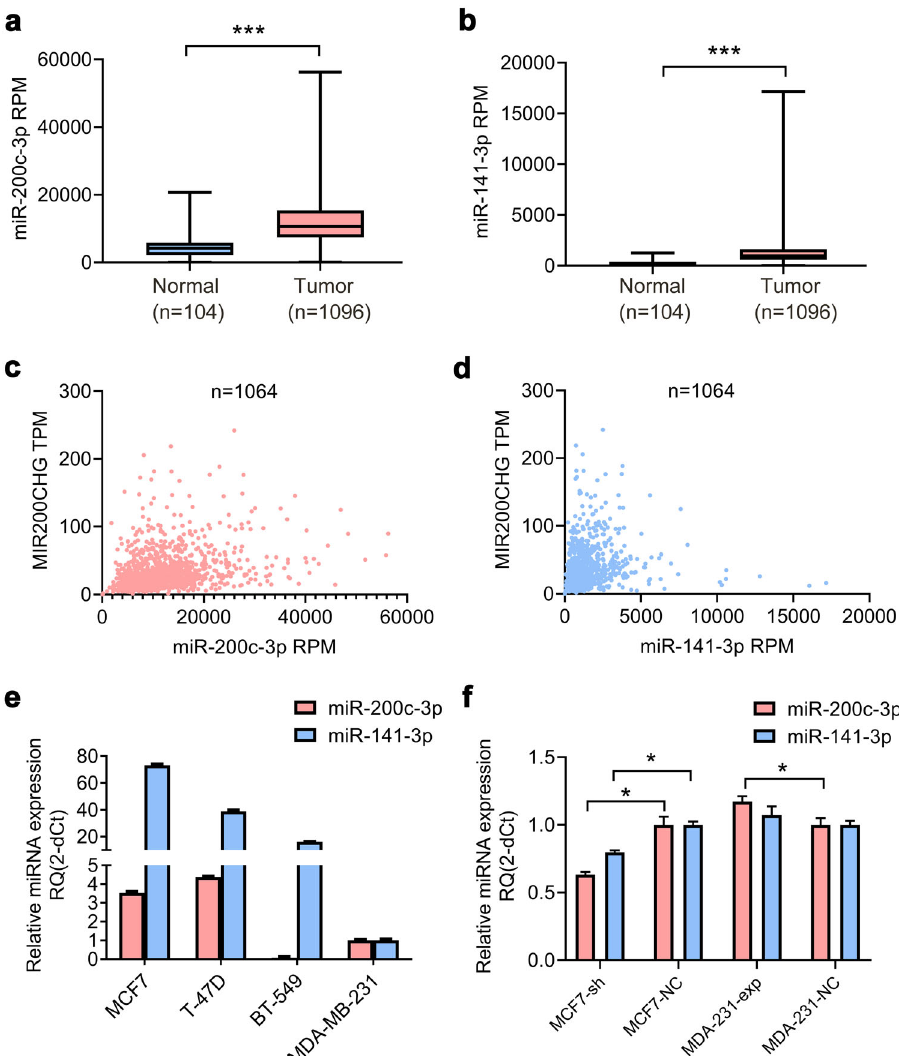
Fig. 7 Correlation between the expression of MIR200CHG and miR-200c/141-3p. a , b Analysis of the expression of miR-200c/141-3p in the TCGA breast cancer array. *** P < 0.001. Boxplots represent medians (center line) and interquartile range (IQR; box), and whiskers represent the maximum and minimum values within 1.5 times the IQR from the edge of the box. c , d Correlations between the expression of MIR200CHG and miR-200c/141-3p were analyzed by TCGA breast cancer array. e Expression of miR-200c/141-3p in breast cancer cell lines (MCF7, T-47D, BT- 549, MDA-MB-231) was analyzed by qRT-PCR. Data were con fi rmed in three independent experiments and are represented as mean ± SEM in triplicates. f The effect of MIR200CHG knockdown or overexpression on the expression of miR-200c/141-3p in breast cancer cells was analyzed by qRT-PCR. The experiment was carried out in triplicate and repeated at least three times. Data are represented as mean ± SEM, and analyzed by two-tailed T test. * P <